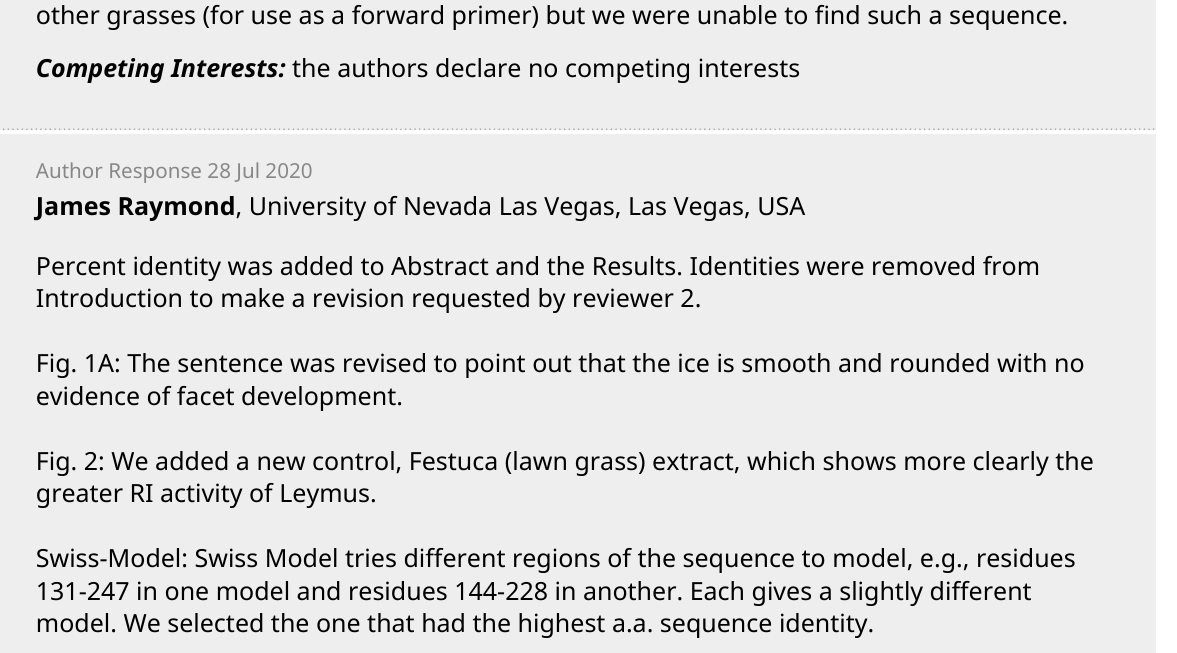
Fig. 1A: The sentence was revised to point out that the ice is smooth and rounded with no evidence of facet development. Fig. 2: We added a new control, Festuca (lawn grass) extract, which shows more clearly the greater RI activity of